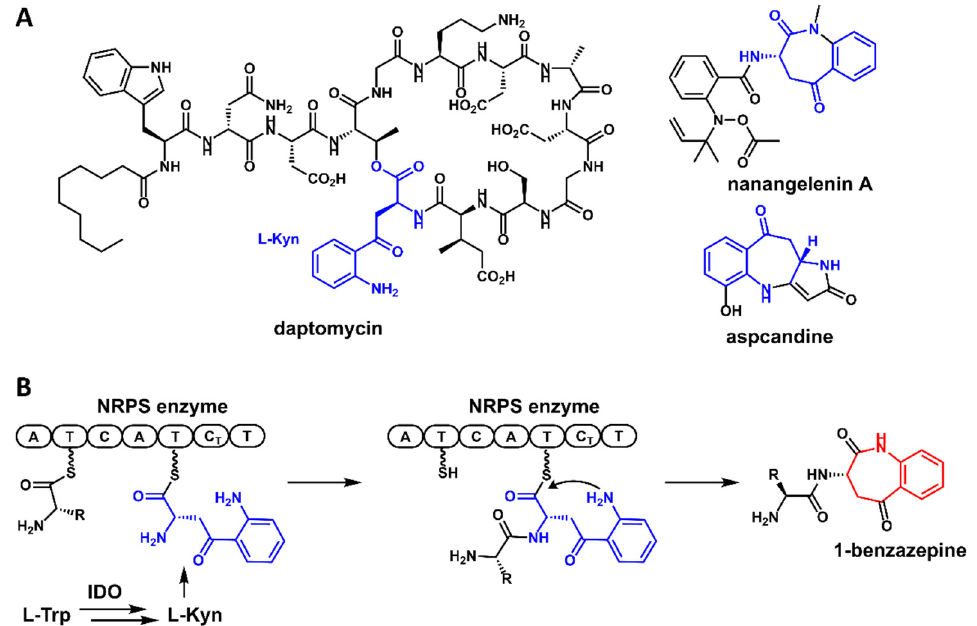
Figure 1. The structures of L -kynurenine ( L -Kyn)-derived natural products ( A ) and the representative biosynthetic route to generating 1-benzazepine-containing compounds from L -Kyn ( B ).